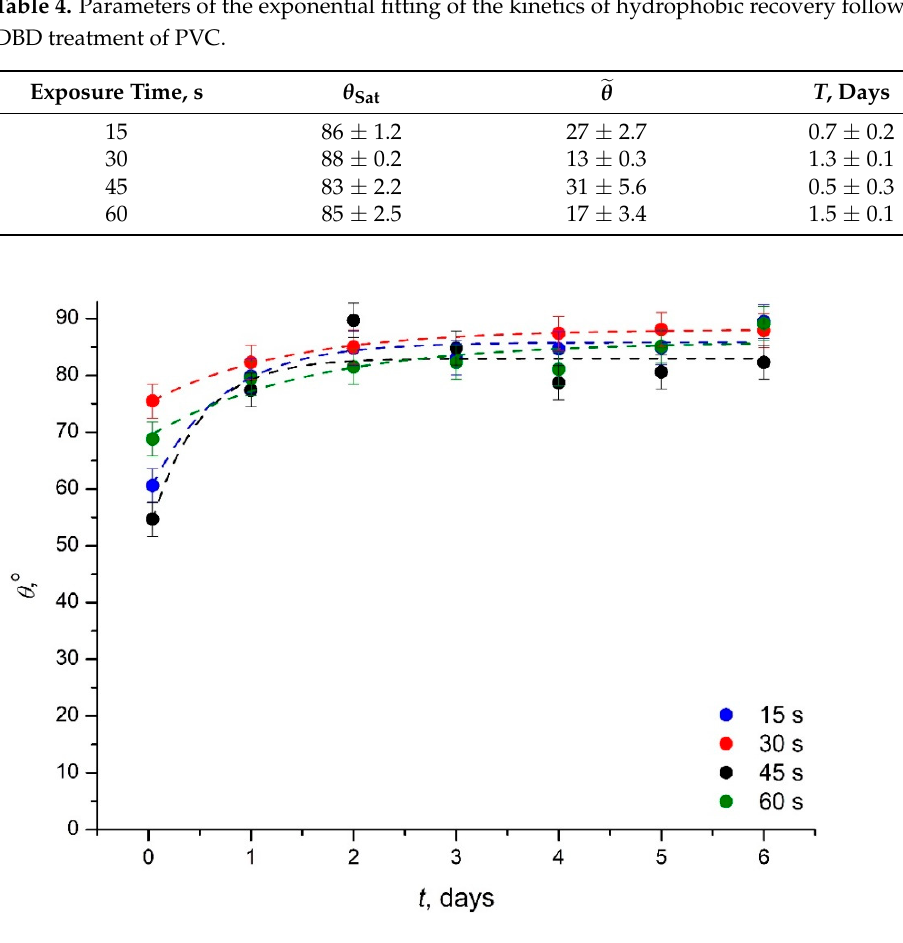
Figure 7. Kinetics of the hydrophobic recovery of PVC following the DBD plasma treatment is depicted. Blue circles correspond to the 15 s treatment; red circles correspond to the 30 s treatment; black circles correspond to 45 s treatment; and green circles correspond to the 60 s treatment. The dashed line corresponds to the exponential fitting with Equation (5). The parameters of fitting are supplied in Table 4.